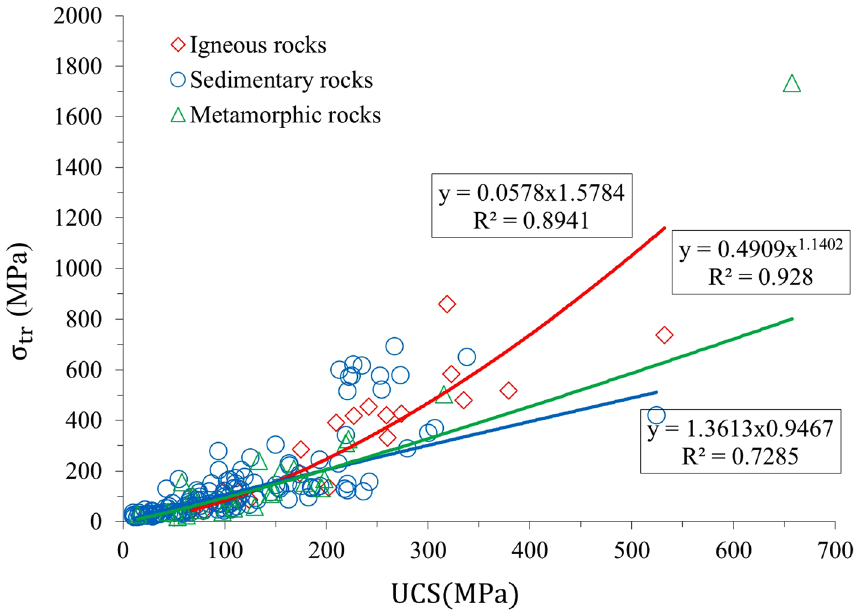
Figure 7. Relationship between σ TR and